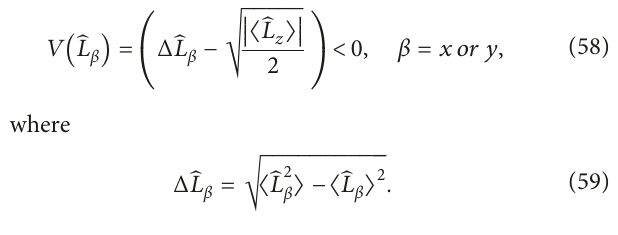
This section is devoted to defining the atomic squeezing periods and comparing them with the entropy squeezing. In Figure 6(a), the ECF effect is neglected and the resonance case is considered. Squeezing is achieved by variable L x and L y . This result completely conforms with the entropy squeezing. Moreover, the squeezing occurs during the in- tervals of collapse. The intervals of squeezing decrease when the nonresonance case is inserted. It also shows a region of squeezing to the variable